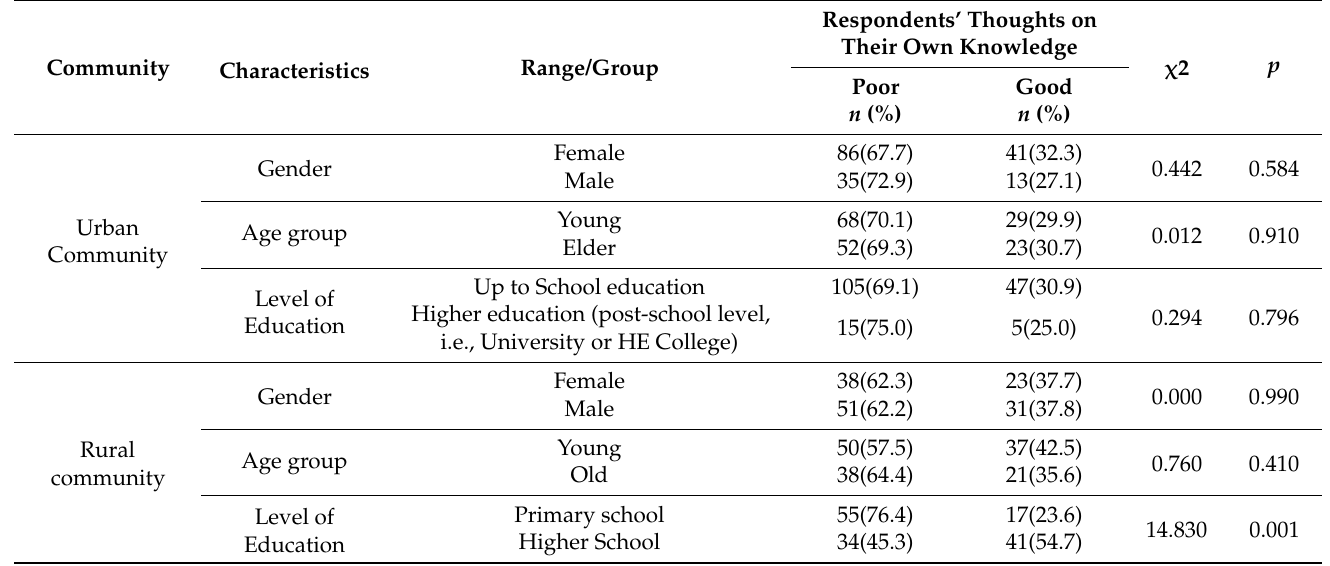
Table 3. Respondents’ perceptions of their own knowledge regarding antibiotics, compared between the demographics of gender, age, and level of education of